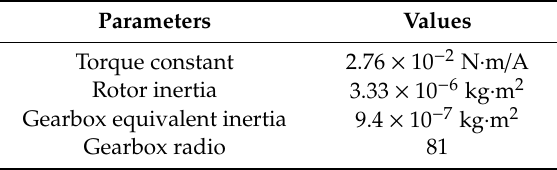
Figure 5. The single joint experiment system. The developed driver consisted of a TI DRV8301-HC-EVM board attached to a microcontroller unit TMS320F28035. Table 3. Motor and gearbox